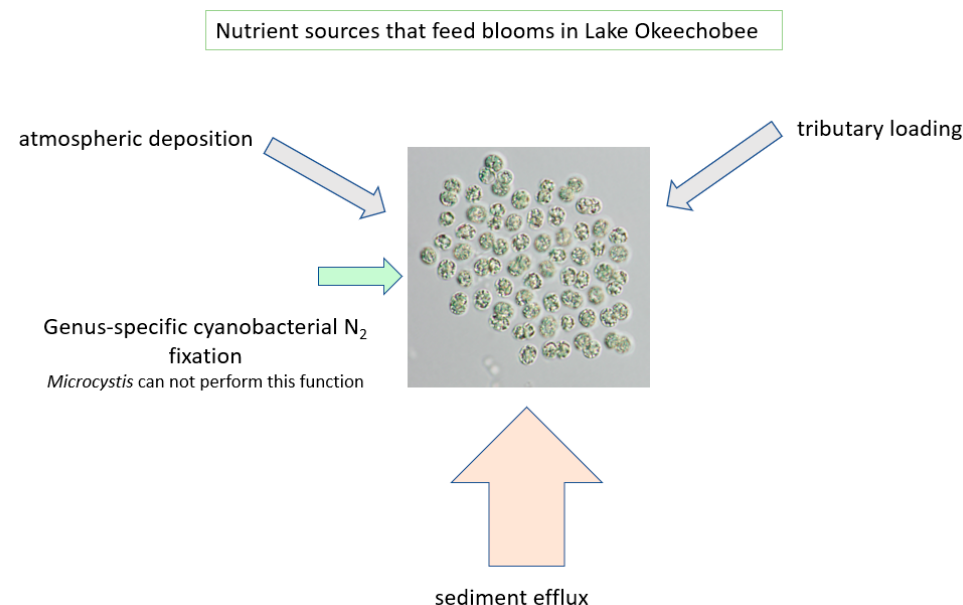
Figure 10. Microcystis blooms are a function of the nutrient releases from the sediments.